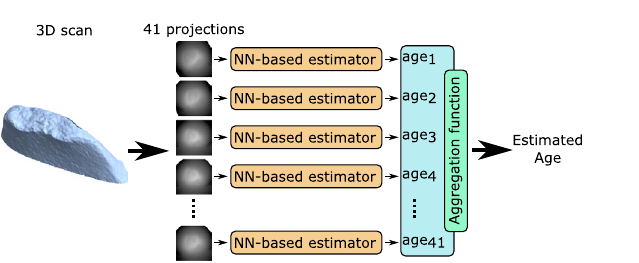
Figure 5. Principle of age estimation for a single individual. There is a single 3D scan for which we build multiple projections (41 in this case). By using the NN-based estimator for each of the projections, we obtain multiple age estimations that are finally aggregated to gain the final estimated age. In this paper, we are presenting the results using the mean aggregation